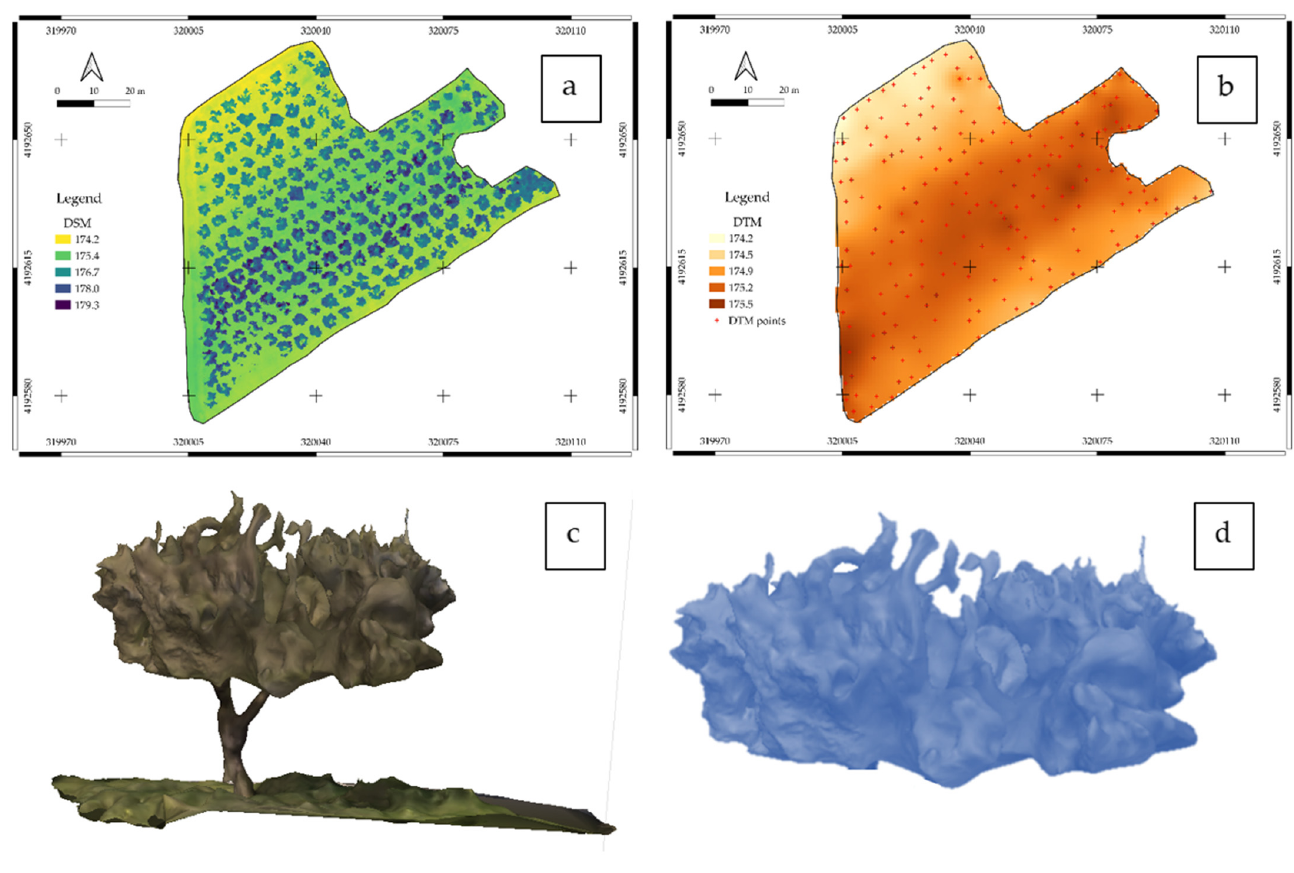
Figure 7. Data processing steps to obtain CV. ( a ) Digital Surface Model (DSM); ( b ) Digital Terrain Model (DTM); ( c ) Representation of the tree; ( d ) Crown volume obtained using Equation (1).